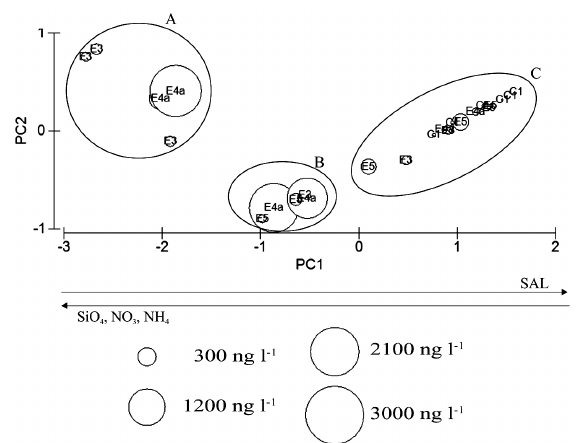
Fig. 5. – Scatterplot of the first two principal components generated by principal component analysis of physicochemical parameters. Overlaid are the alloxanthine concentration values: A, low salinity and high nutrient samples from the surface layer; B, samples from the freshwater/seawater interface (halocline); C, high salinity and low nutrient samples from deeper layers of estuarine stations and all samples from station C1.